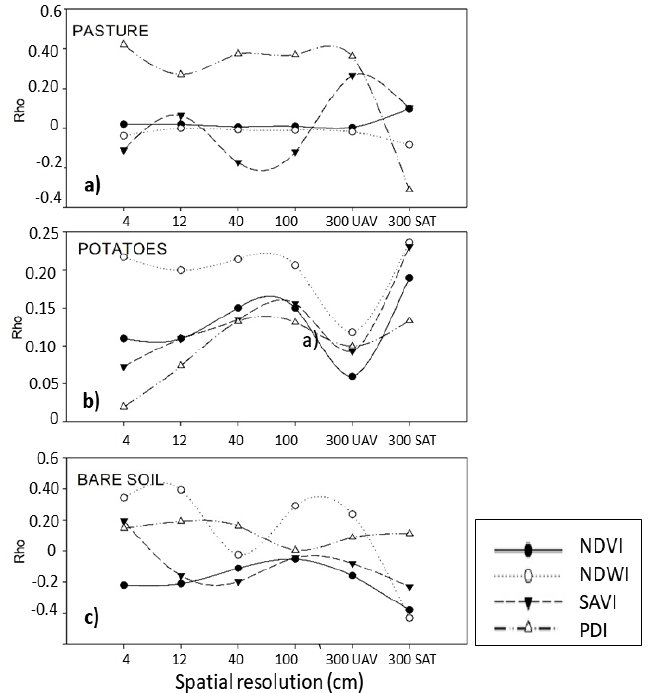
Figure 9. Rho correlation between the index and soil moisture according to land use and spatial resolution. ( a ) pasture study site, ( b ) potatoes study site, ( c ) bare soil study site. Source: Current research